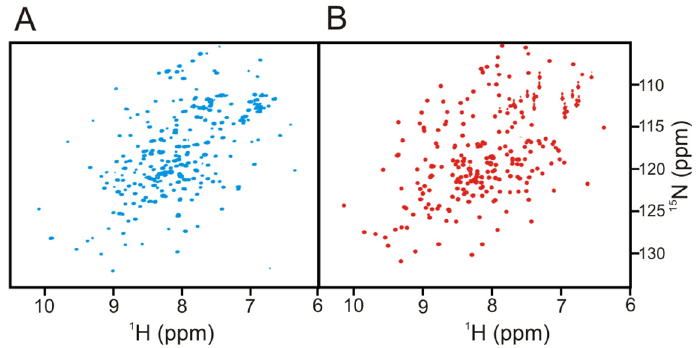
Fig 4. NMR spectra of yeast Adk1 and E . coli Adk. (A) 1 H- 15 N HSQC spectrum of Adk1 yeast (B) 1 H- 15 N HSQC spectrum of Adk eco . The spectra were acquired at 20°C and show that both enzymes are properly folded at the conditions used in this study.